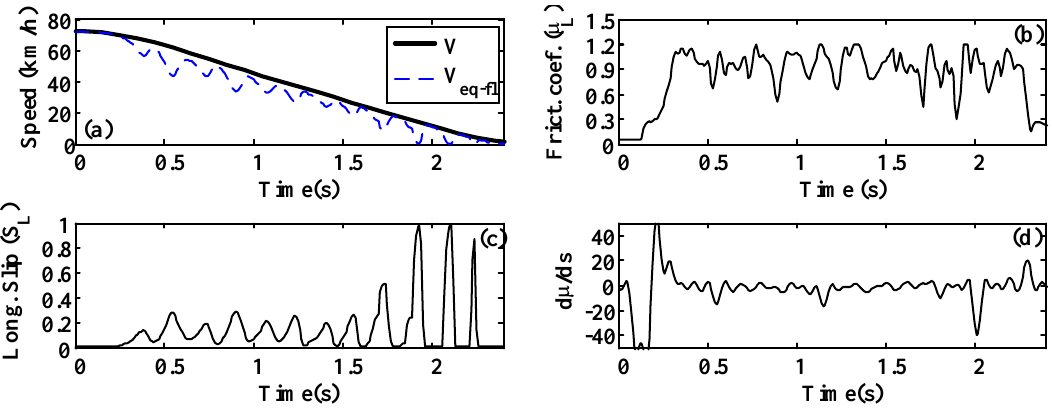
Figure 20. Dry asphalt. ( a ) Speed; ( b ) Friction coefficient; ( c ) Longitudinal slip; ( d ) Slope of µ–s curve.